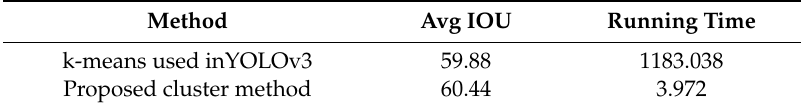
Figure 2. Avg IOU of the proposed cluster method and the AFK-MC 2 method on the MS COCO dataset. Table 1. Comparison between original YOLOv3 and proposed cluster method on the MS COCO dataset: Avg IOU (%) and running time (s).